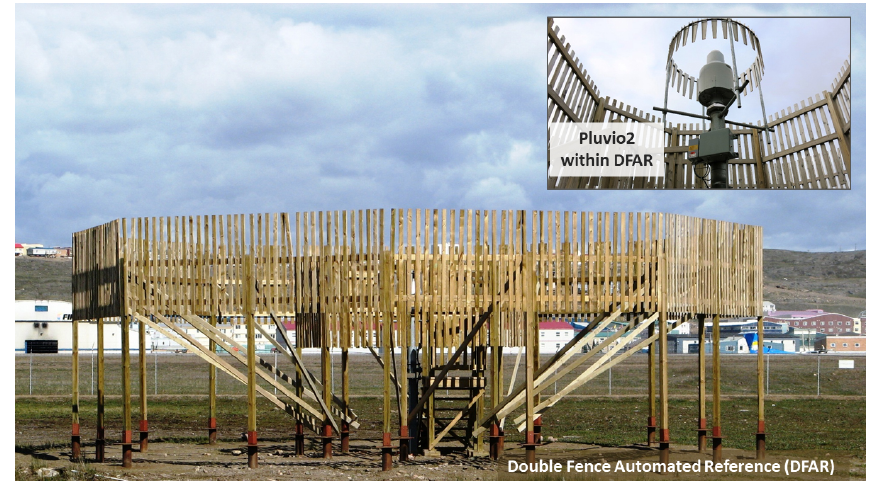
Figure 3. Double-fence automated reference (DFAR) configuration at the Iqaluit supersite. Inset: close-up of the single-alter shielded Pluvio2 precipitation gauge (centre) within the inner wooden